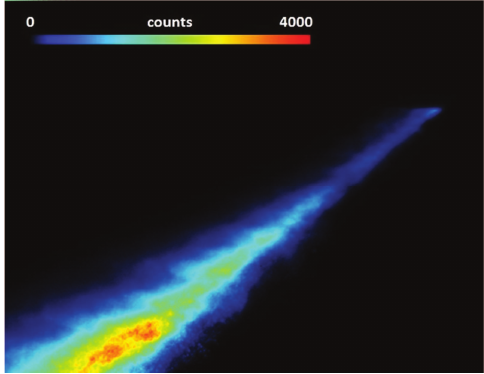
Fig. 8. Instantaneous Mie image after background subtraction